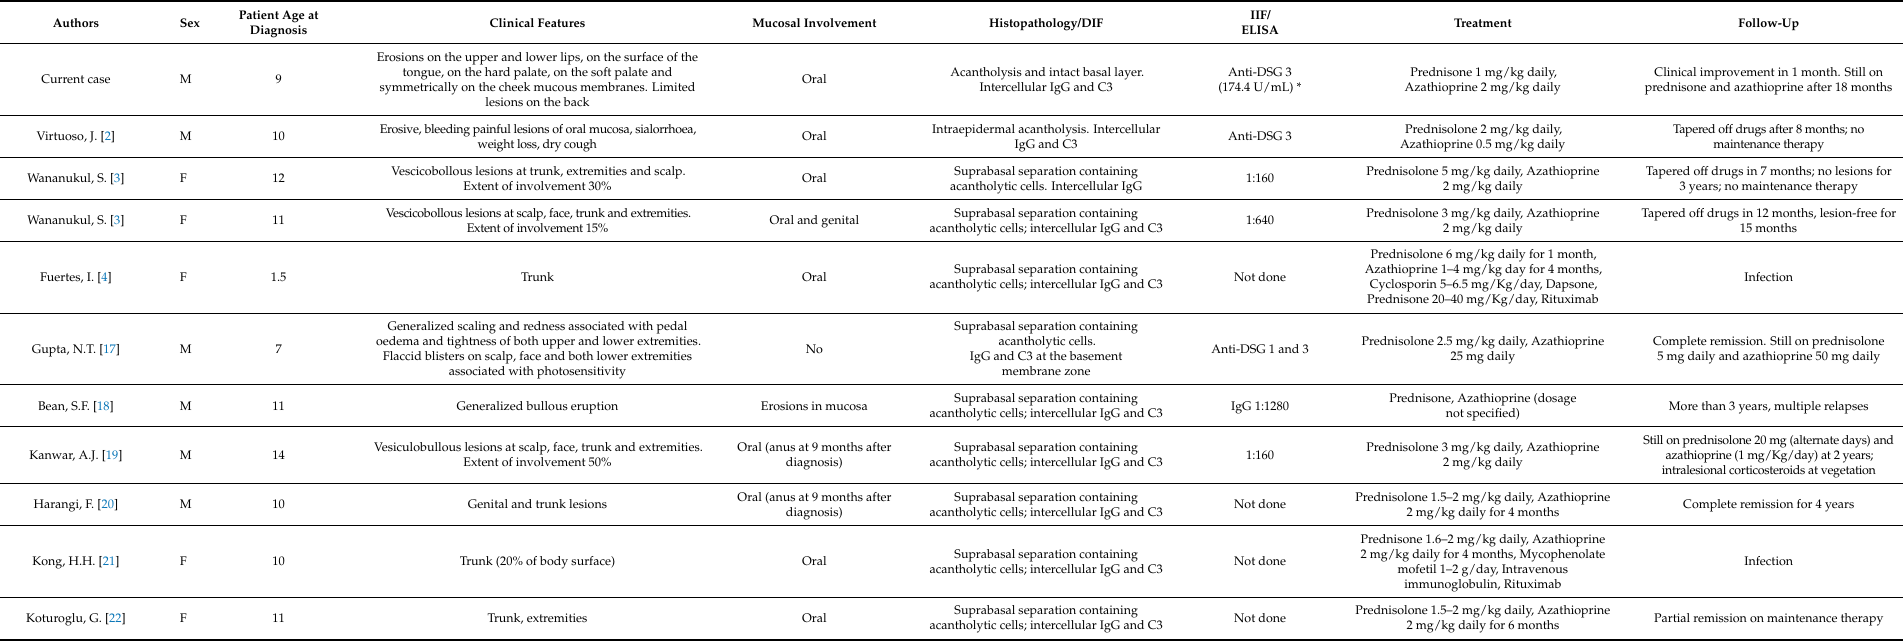
Table 1. Description of similar cases of CPV treated with steroids and azathioprine reported in the